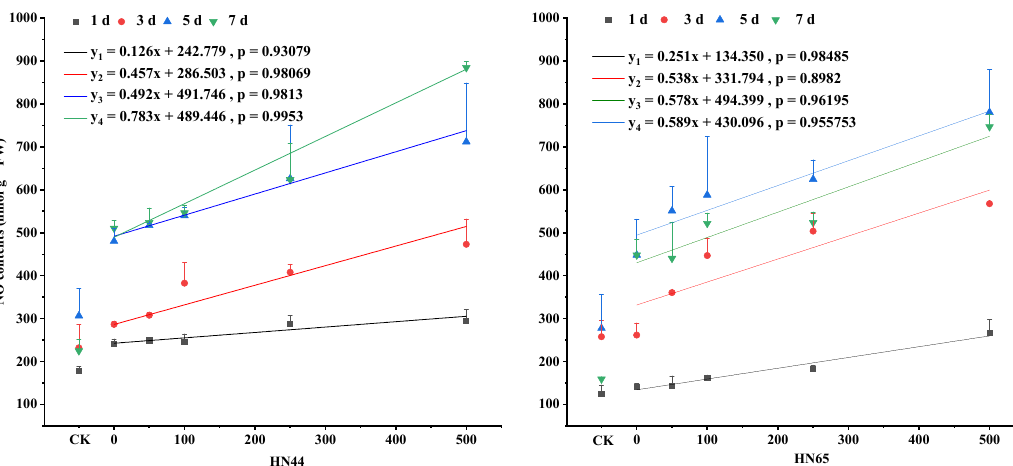
Figure 1. Changes in NO content during SNP mitigation of drought stress. NO stands for nitric oxide. The X -axis, CK represents the control, and the remaining numbers are SNP concentrations sprayed. Values (mean ± SE) are the averages of three independent experiments.